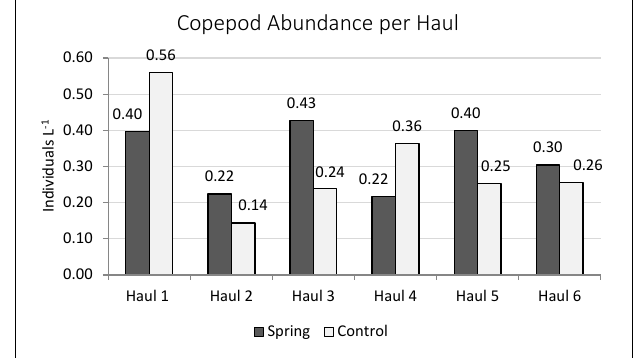
FIGURE 12 | Categorized frequencies of counted fish around a submarine spring and a seawater control site. The secondary axis depicts the ratio Spring/Control. Note that the left (Frequency) axis is on logarithmic scale while the right (Ratio) axis is